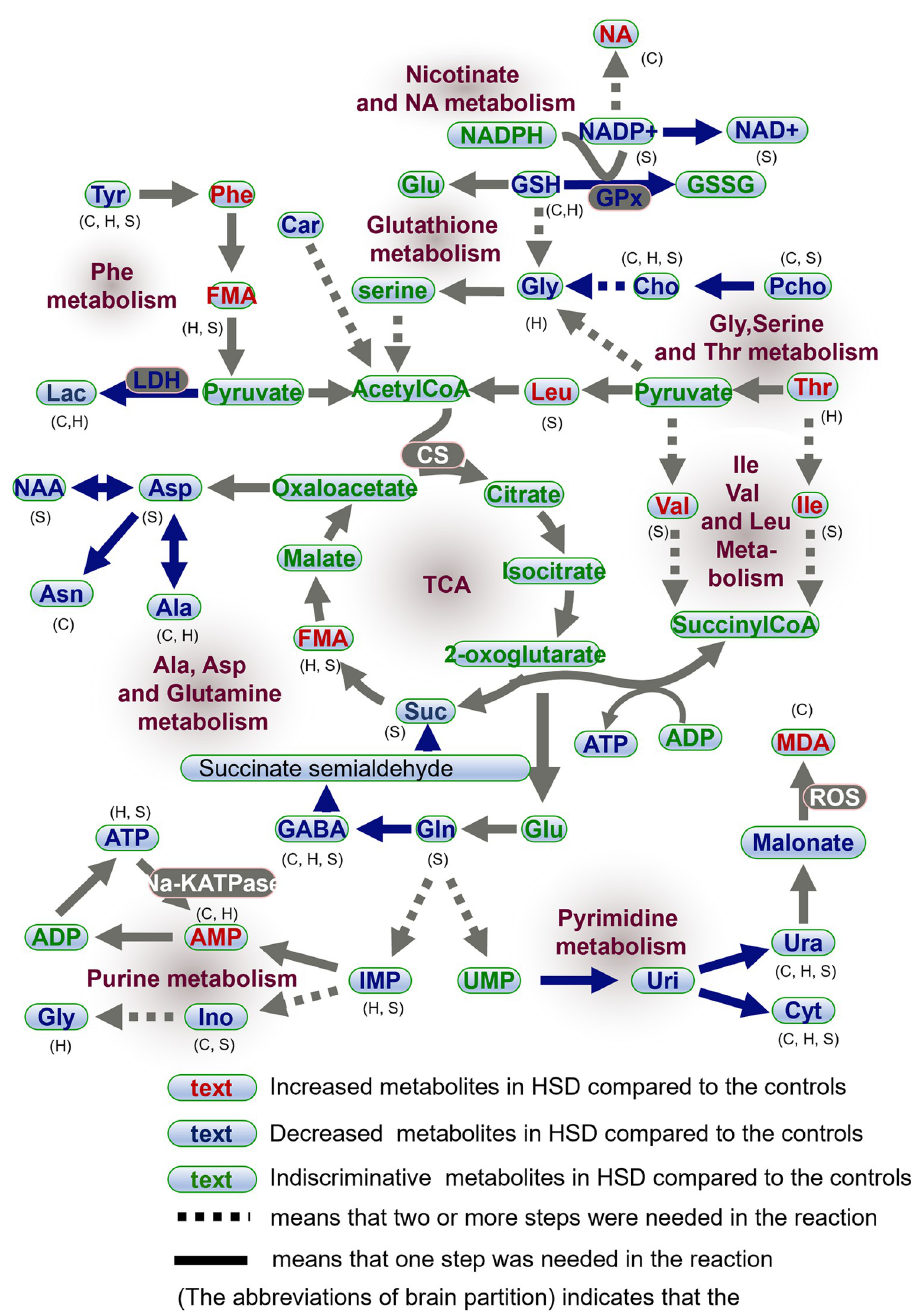
Fig 7. Schematic overview of inferred changes in the potential cerebral metabolic pathways post hyperbaric heliox saturation.